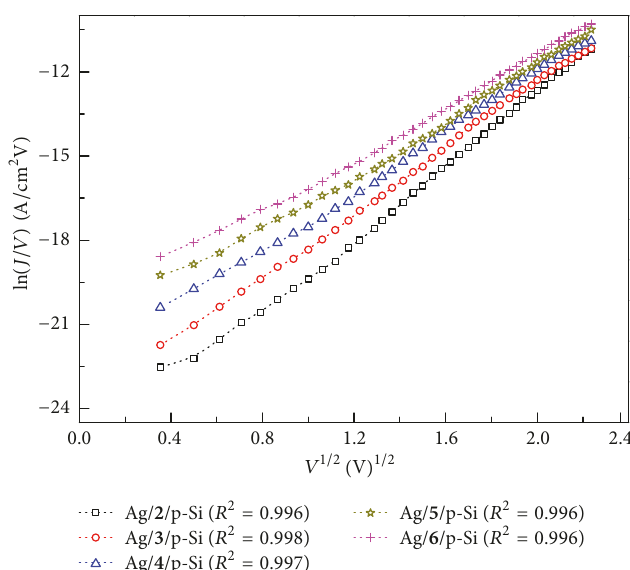
Figure 4: 𝐽 - 𝑉 plots for forward (a) and reverse bias (b) conditions.